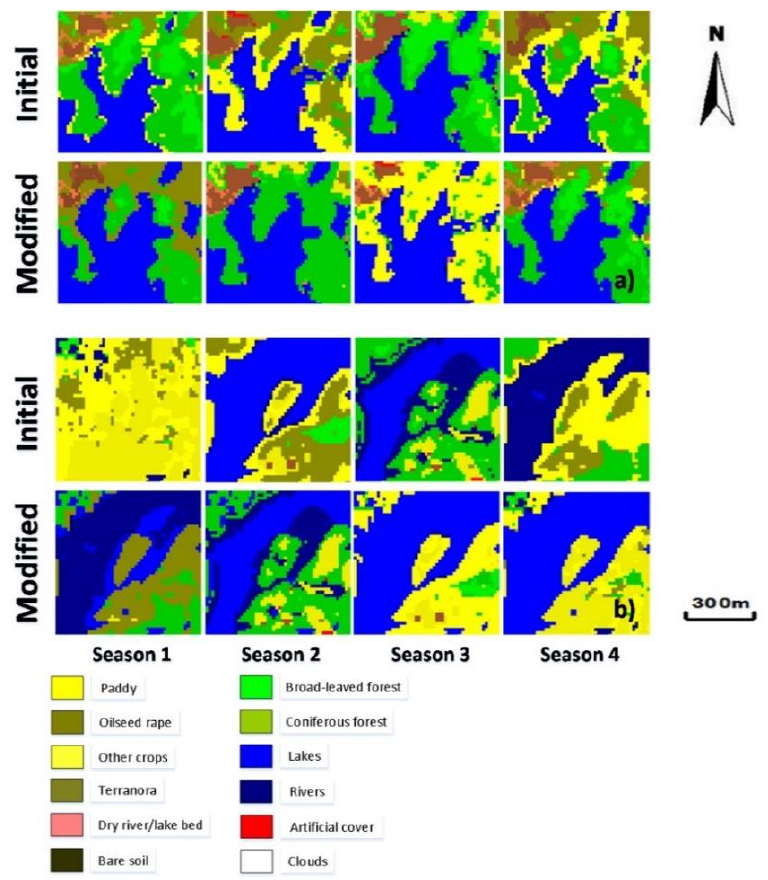
Figure 6. Details of land cover maps ( a , b ) details for different locations.